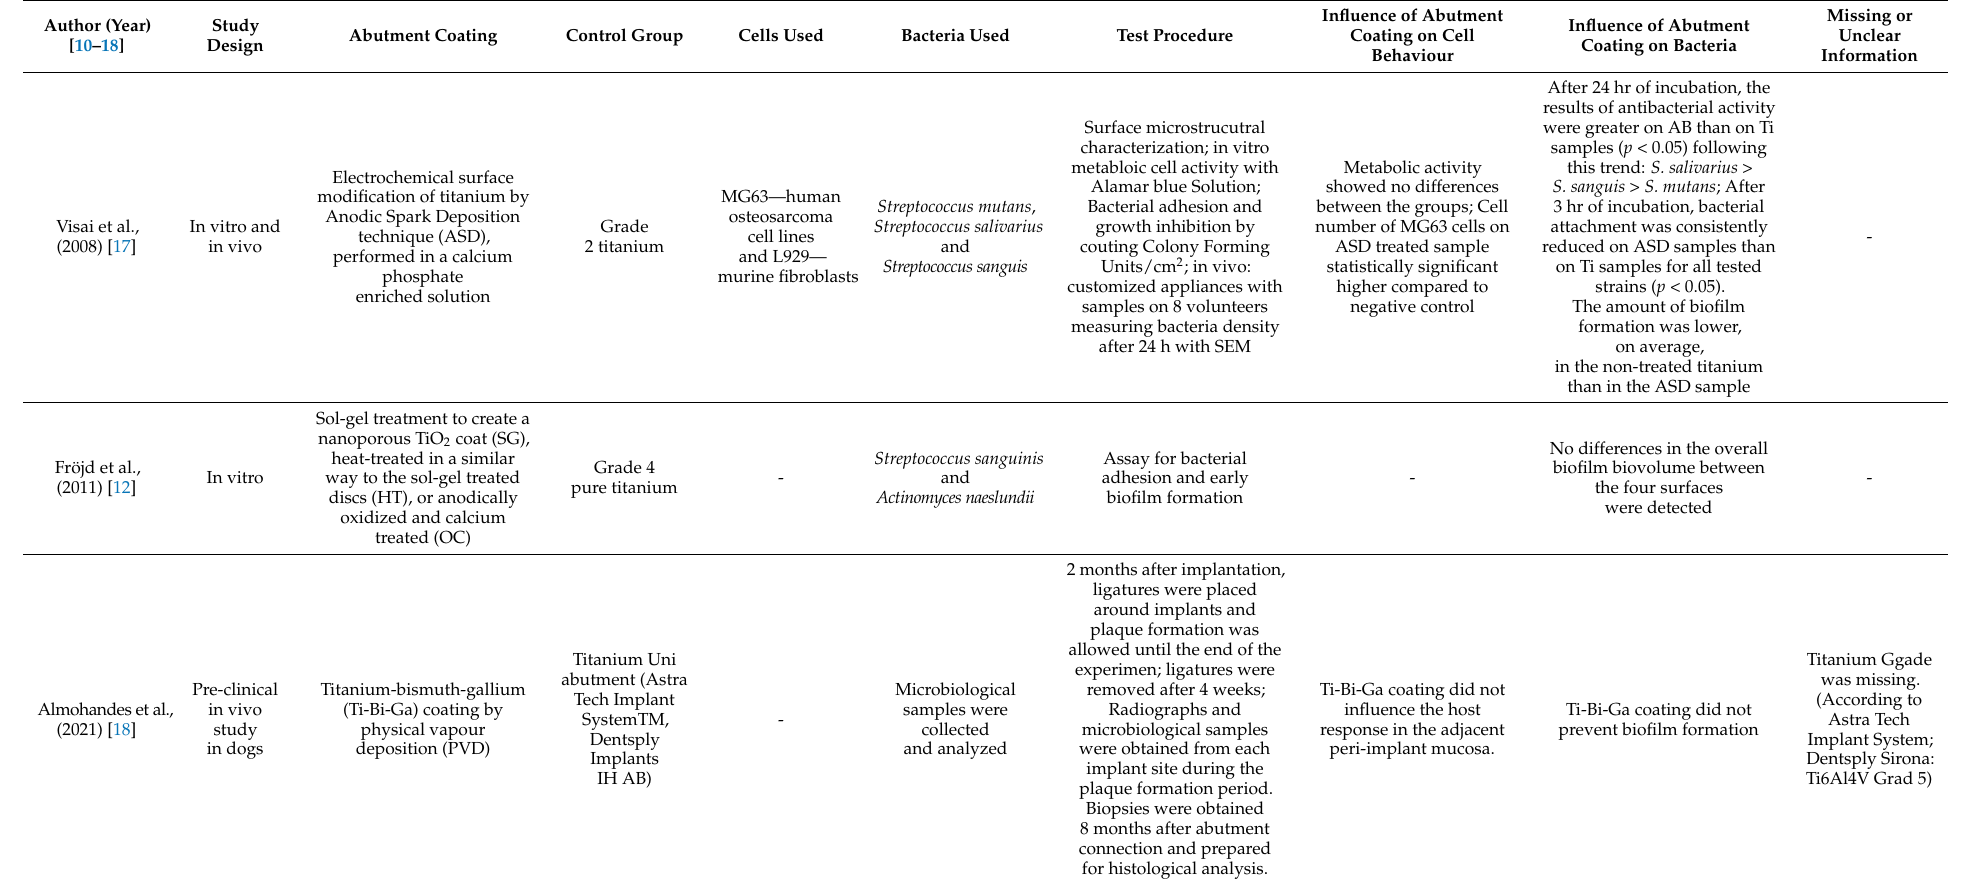
Table 2. Study selection and extracted data from the included